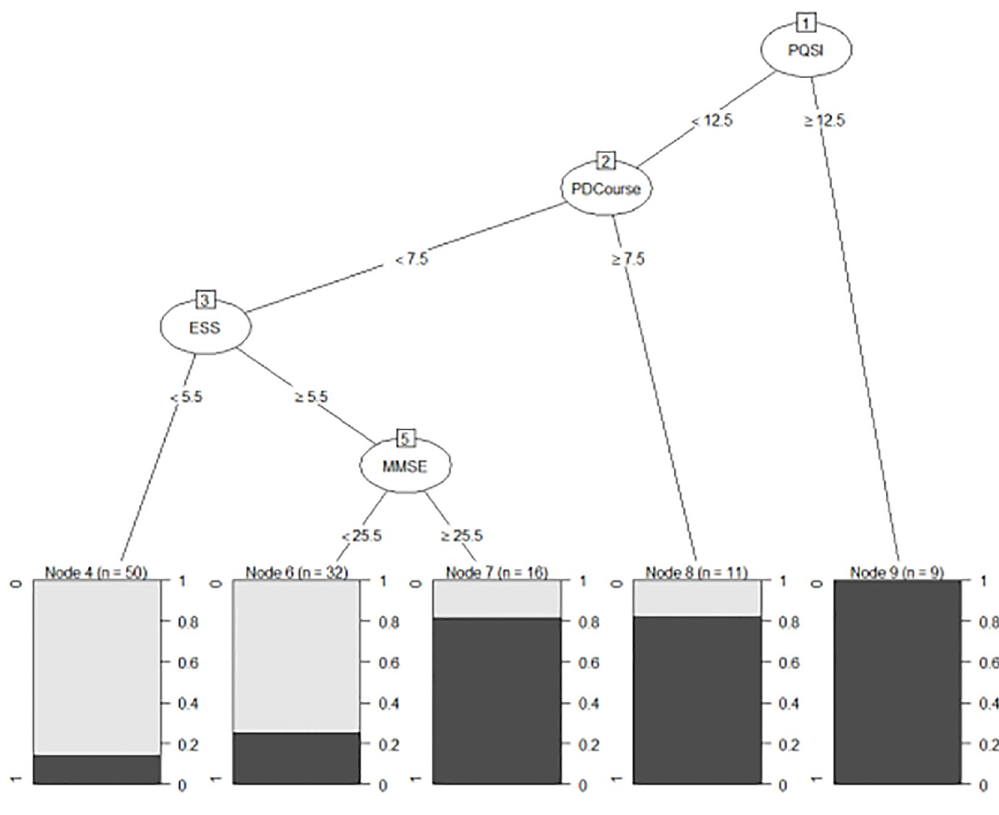
Fig 1. Visualization of decision tree